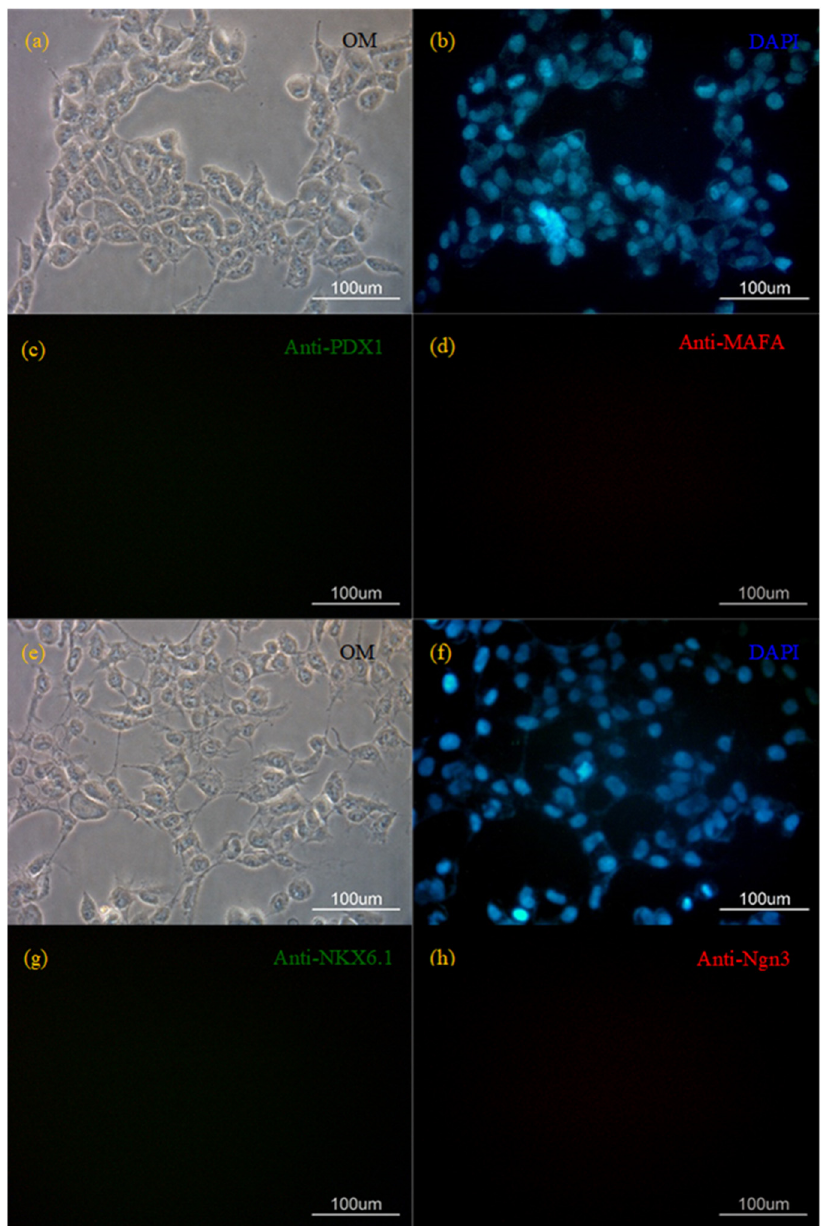
Figure 5. Immunohistochemistry (IHC) images of ( a , e ) optical, ( b , f ) DAPI, ( c ) anti-PDX1, ( d ) anti- MAFA, ( g ) anti-NKX6.1, and ( h ) anti-Ngn3 staining in HEK293T cells treated with MPIPs/RNPs.